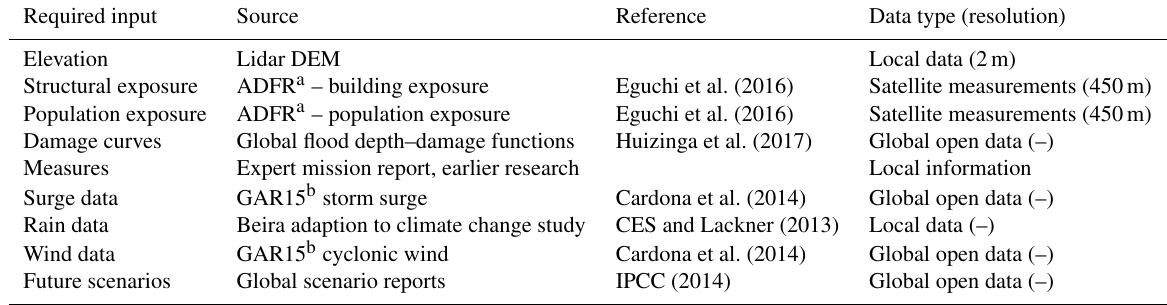
Table 2. Data sources for the FLORES model in Beira.